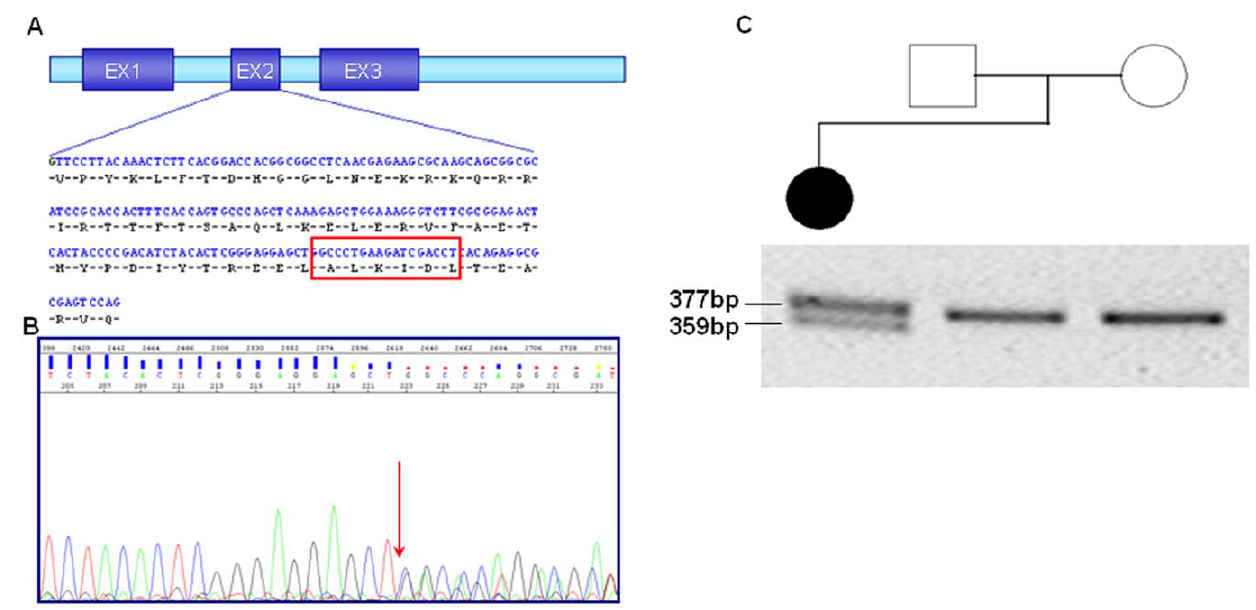
Figure 1. PHOX2B deletion detected in exon 2. (A) Schematic representation of PHOX2B showing both nucleotide and amino acid sequence of exon 2; the 18bp corresponding to the deletion are boxed. (B) Sequence chromatogram of PHOX2B exon 2; the arrow indicates the beginning